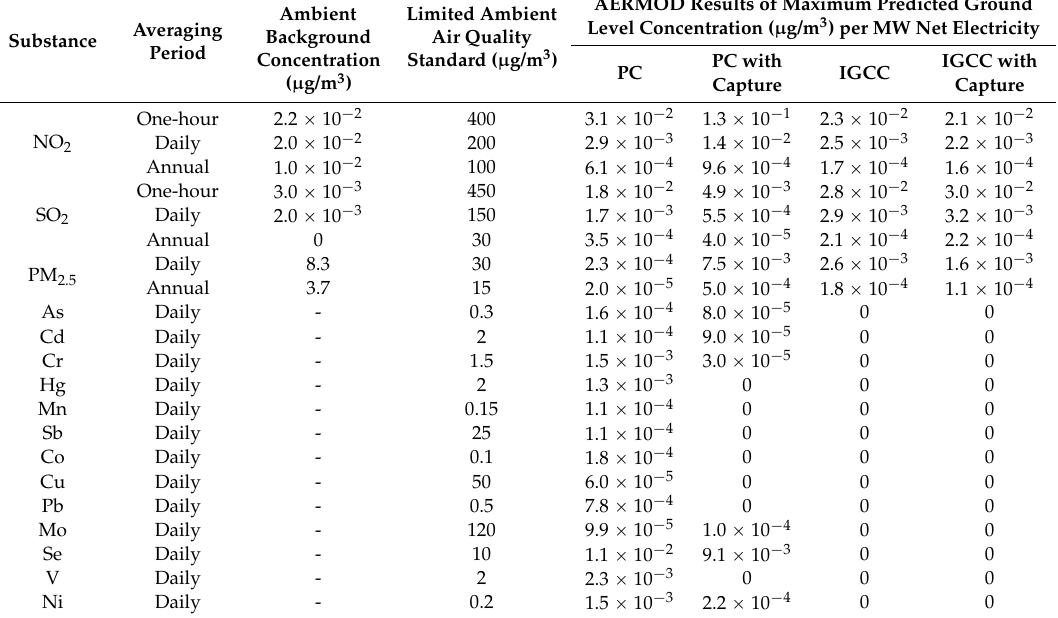
Table 8. AERMOD results: maximum predicted ground-level concentration per MWe produced.